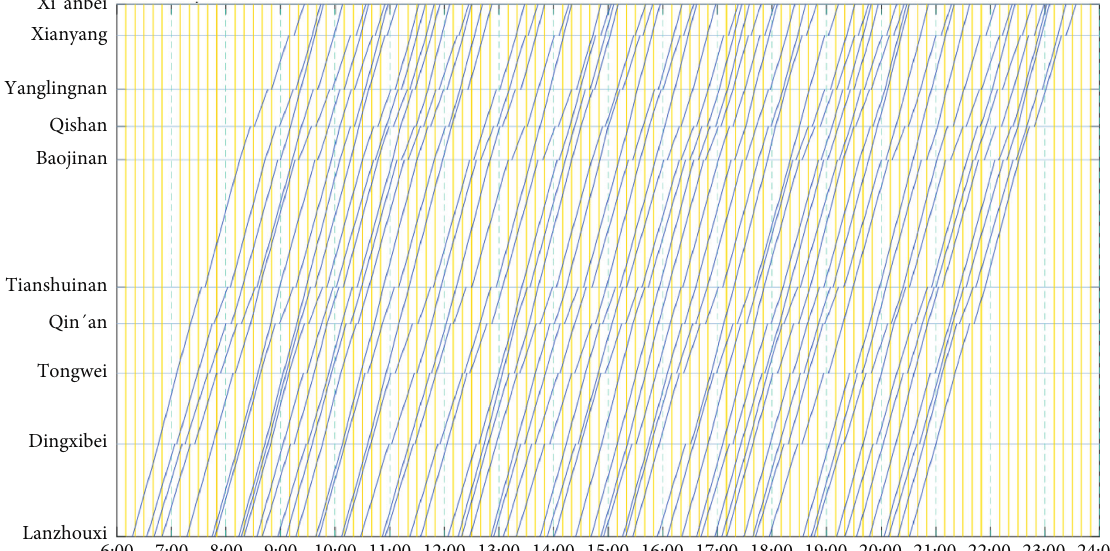
Figure 16: Train diagram based on optimized train